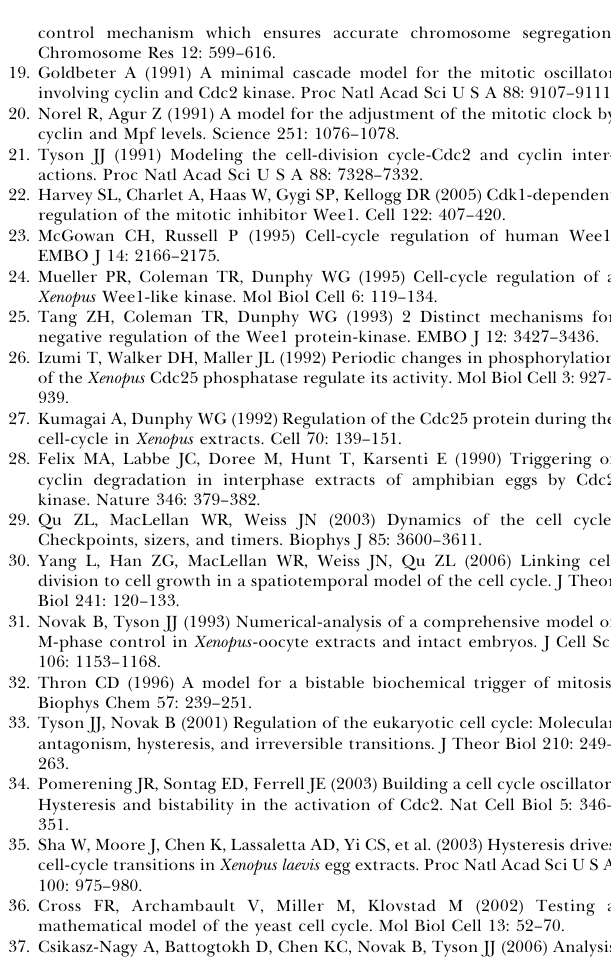
(A) Maximum intensity projections of a cell entering mitosis. The centrosomes are indicated with arrows. (B) The average time in minutes, with SD in brackets, between early mitotic events. Time is counted from the first image where the indicated event is observed. See text for details. Figure S9. Effects of Cdk1 Attenuation on Mitotic Progression (A) Details of early mitosis revealing delayed spindle formation in cells entering mitosis with reduced Cdk1 levels. (B) A cell arresting at the G2-M transition after centrosome separation. Mitotic entry after centrosome separation usually occurs within approximately 10–20 min in U2OS cells, e.g., see Figure 5D. Found at doi:10.1371/journal.pbio.0050123.sg009 (7.0 MB PDF). Figure S10. Cyclin B1–Cdk1 Complexes from pSuper- or pSuper- Cdk1–Treated Cells Are Comparably Active (A) Mitotic U2OS cells were collected after treatment with either pSuper or pSuper-Cdk1. Extracts of these cells were blotted with indicated antibodies. Importantly, next to a reduction of Cdk1 levels, cyclin B1 levels also were reduced. This indicates that only around 40% of cyclin B1–Cdk1 complexes could be formed in pSuper-Cdk1– treated cells compared to control cells. (B and C) Cell extracts from (A) were subjected to immunoprecipi- tation with cyclin B1 antibodies for 4 h at 4 8 C. Next, the cyclin B1 immunoprecipitates were incubated with 32 P- c ATP for 30 min with Histon H1 as substrate. We separated different amounts of the reactions on gel to correct for possible differences in cyclin B1 and/or Cdk1 levels in the IPs. Western blots were performed using cyclin B1 and Cdk1 antibodies after exposures were taken using Phosphor- Imager films. Intensities were measured and background was subtracted using MetaMorph software and Excel. The highest signal in the pSuper samples was set at 100%, and the estimated